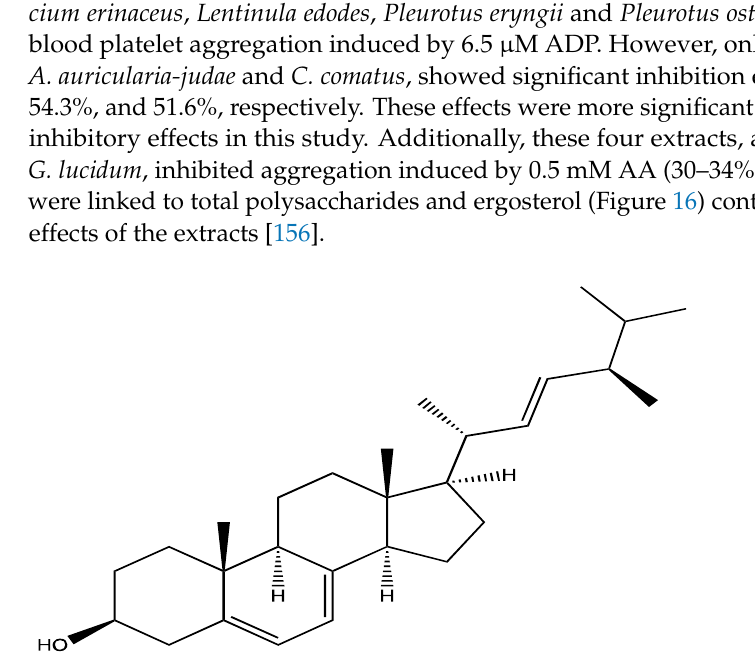
Figure 16. Structure of ergosterol.